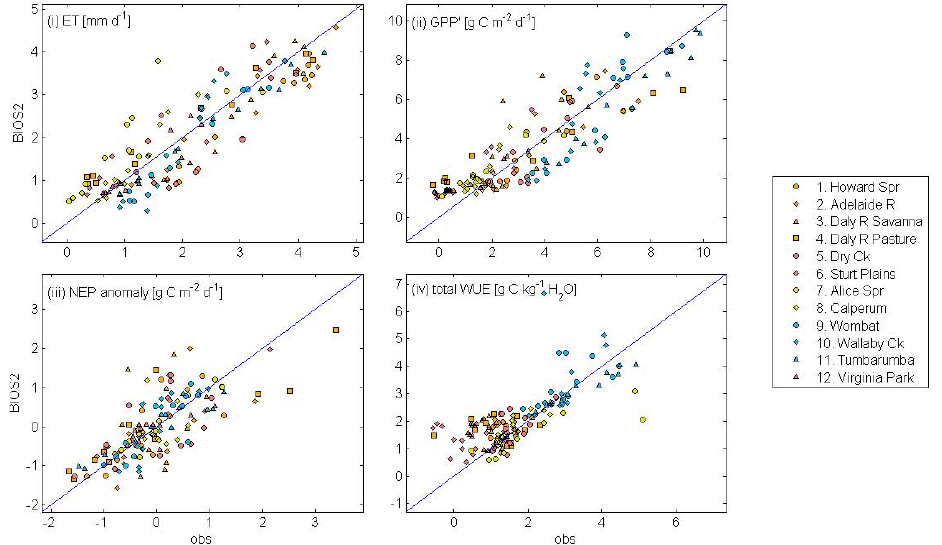
Fig. 7. Scatterplots of ensemble monthly mean (averaged over obs years) model predictions vs Ozflux observations of (i) ET; (ii) GPP 0 ; (iii) NEP anomaly; and (iv) total WUE (=GPP 0 /ET).